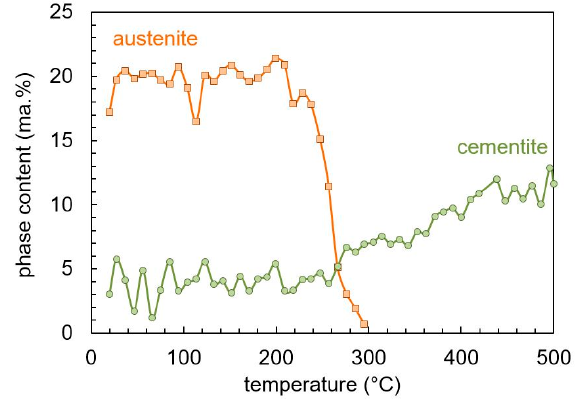
Figure 8. Phase contents of SAE 52100 during tempering determined by in-situ X-ray measurement.